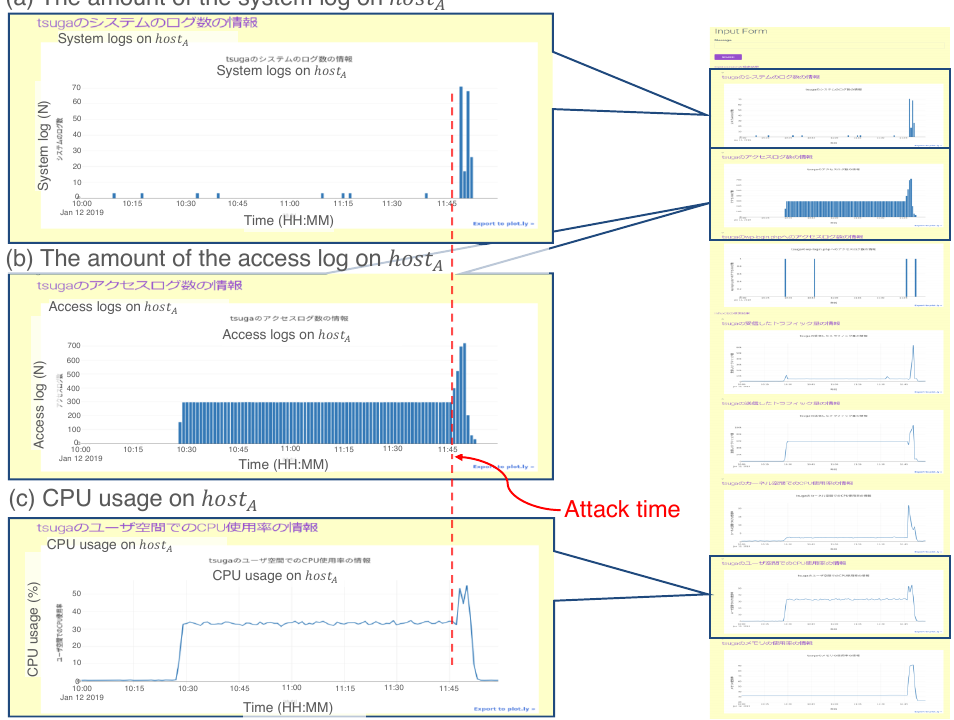
Figure 14. Example result for the prototype system in Case 3. We assert three remarkable results: ( a ) the amount of the system log on host A , ( b ) the amount of the access log on host A , and ( c ) central processing unit (CPU) usage on host A